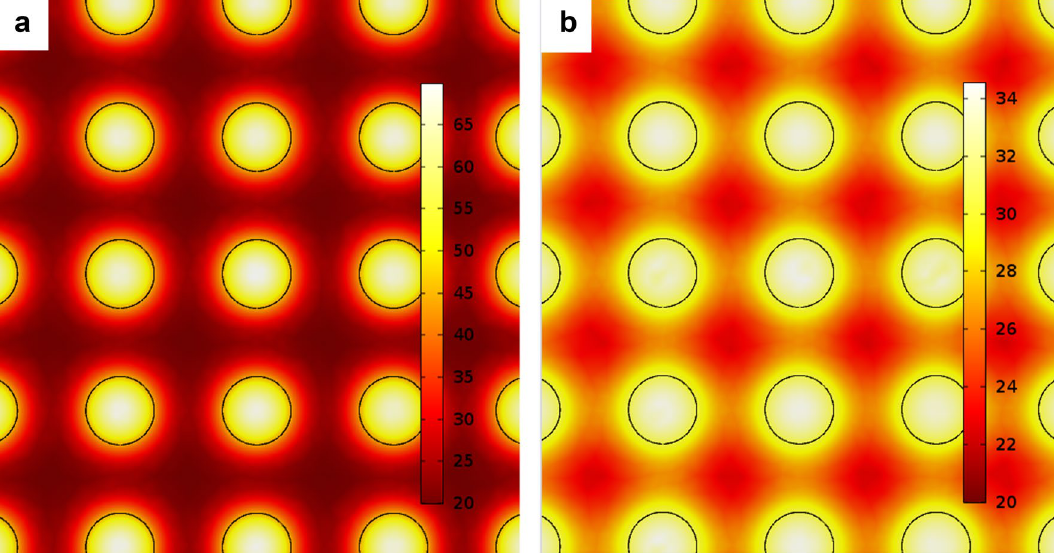
Figure 8. Temperature distribution after instantaneous heating of stainless steel surface with laser multi-spots up to the melting point: ( a ) at 1 µs after laser pulse, ( b ) at 3 µs after laser